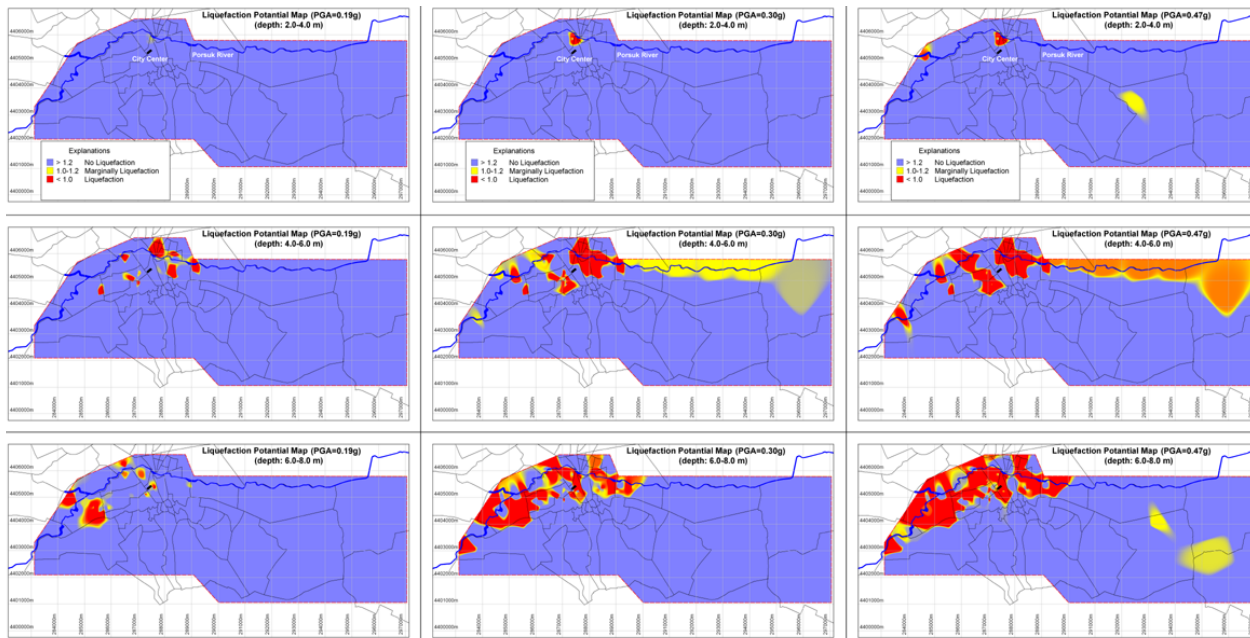
Fig. 11. Liquefaction potential map of the study